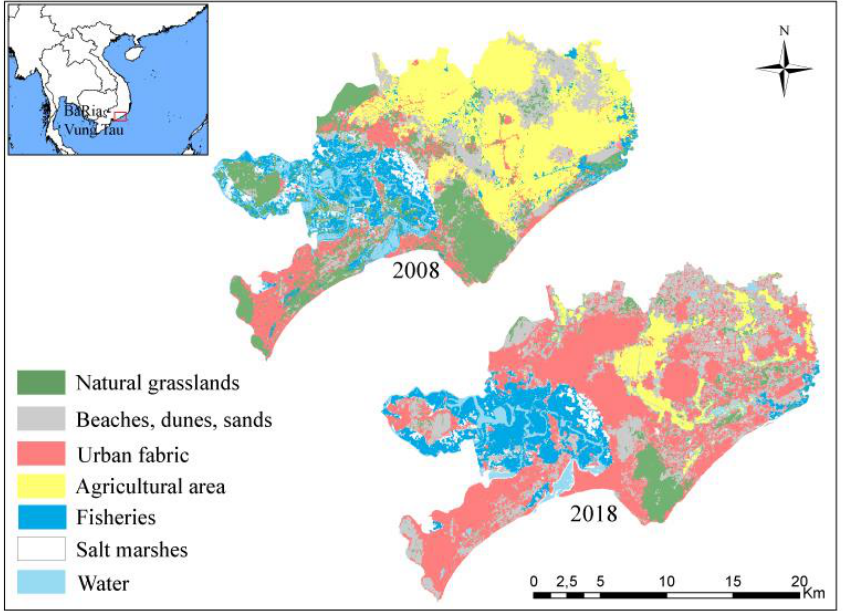
Figure 14. Land cover/land use patterns in Vung Tau Province, Vietnam during 2008–2018. Table 9. Confusion matrices for the land cover / land use changes maps of Cam Pha area (Figure 12), Da Nang City area (Figure 13) and Vung Tau Province (Figure 14) in Vietnam. Area Campha